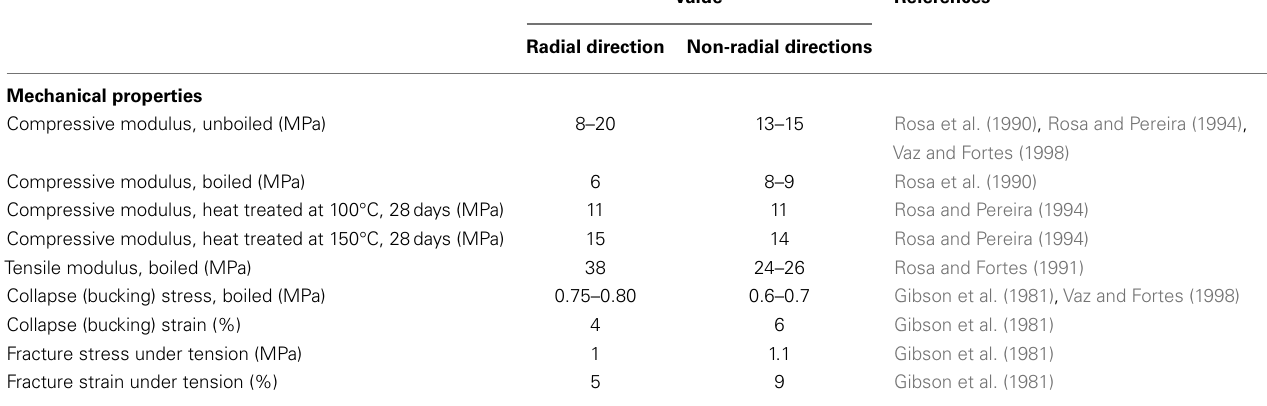
Table 2 | Mechanical properties of cork